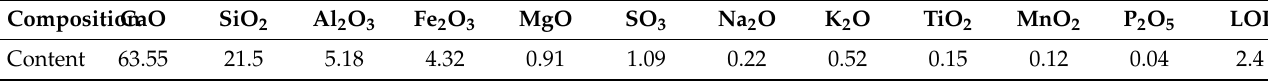
Table 1. Composition of cement (wt.%).